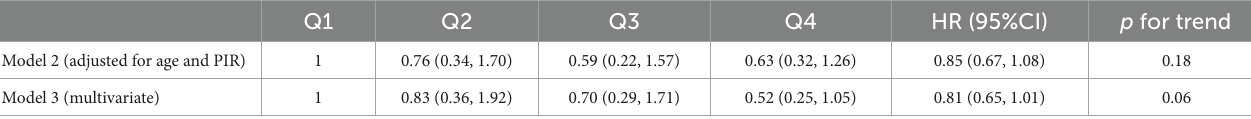
than 50 and current smokers (Supplementary Figure S2E). However, the intake of flavanones was positively associated with the cerebrovascular disease mortality in people age 50 and above, both genders, people with high PIR, whites, non-smokers, former smokers, and mild alcohol users (Supplementary Figure S2I). Total isoflavone intake and all-cause mortality were negatively associated in former smokers and people with high PIR (Supplementary Figure S2B). The intake of isoflavone did not show inverse association with heart disease mortality in any subgroups (Supplementary Figure S2F). The inverse association between total isoflavone intake and cerebrovascular mortality was significant in males, people with medium PIR, current smokers, and mild alcohol users, and former alcohol users (Supplementary Figure S2J). In the female participants and former drinkers, the intake of flavan-3-ols was inversely associated with all-cause mortality (Supplementary Figure S2C). The intake of flavan-3-ols was inversely associated with heart disease mortality in females, blacks, people never drank, and former drinkers, while the intake of flavan-3-ols was positively associated with heart disease mortality in mild alcohol users (Supplementary Figure S2G).